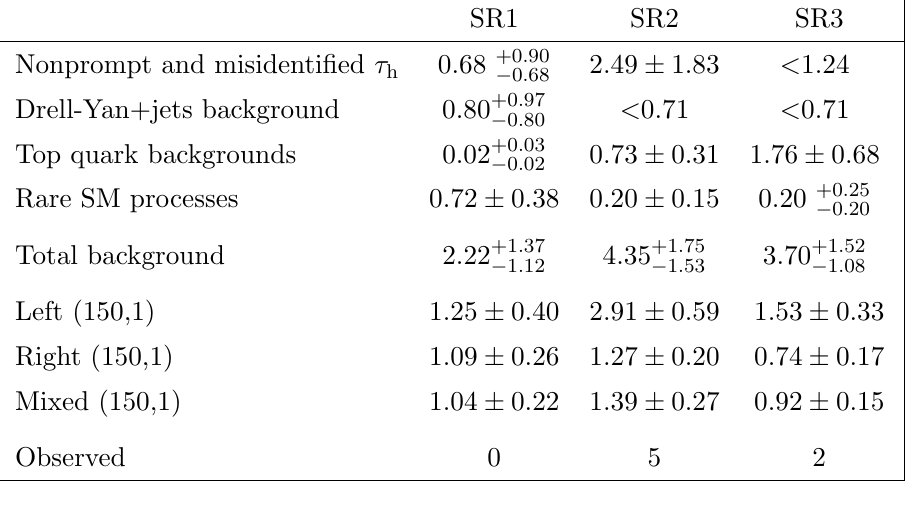
Table 10. Final predicted and observed event yields in the three SRs de(cid:12)ned for the (cid:28) state with all statistical and systematic uncertainties combined. For the background estimates with no event in the corresponding data control region or in the simulated sample after the SR selection, the predicted yield is indicated as being less than the one standard deviation upper bound evaluated for that estimate. The central value and the uncertainties for the total background estimate are then extracted from the full pre-(cid:12)t likelihood. Expected yields are also given for signal models